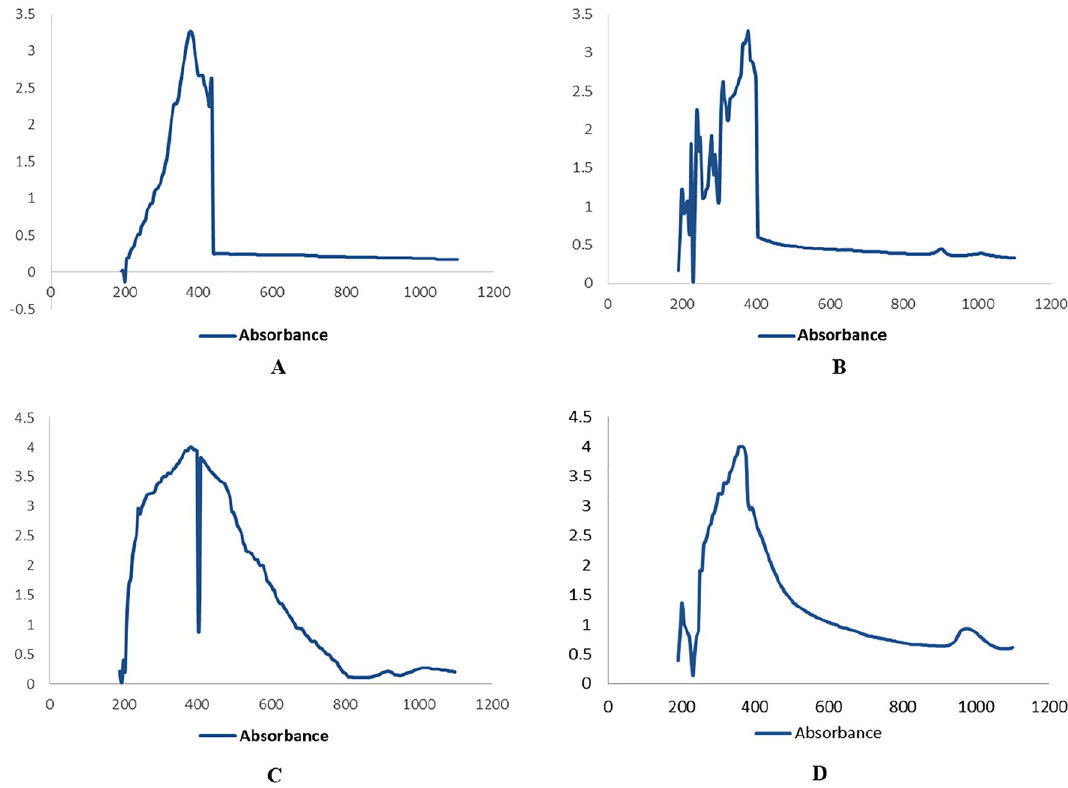
Figure 1. UV Visible absorption spectra of zinc oxide nanoparticles. ( A ) n-Hexane ( B ) Ethyl Acetate ( C ) Methanol ( D )